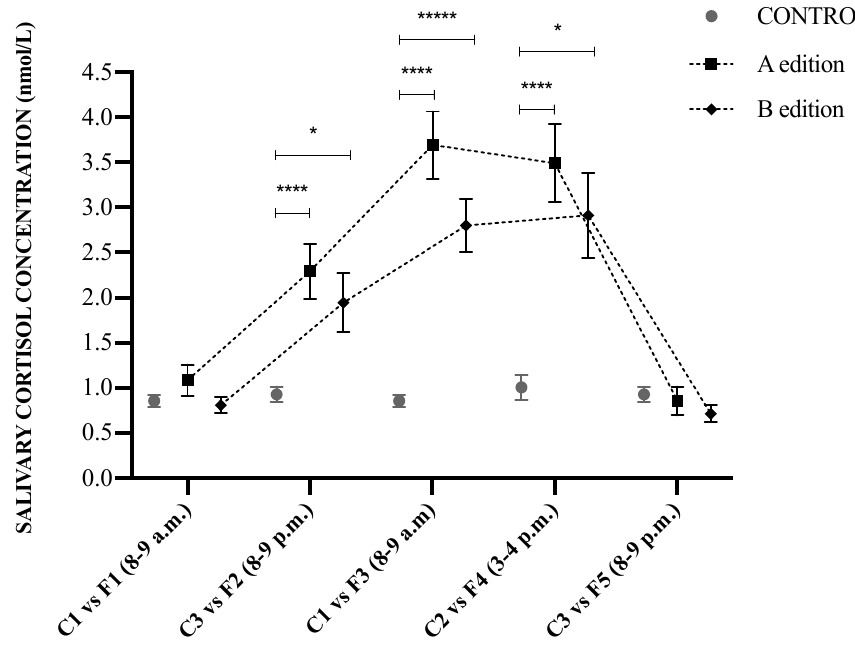
Figure 3. Mean ± SEM salivary cortisol concentrations (nmol/L) from the evaluated horses during the festival days (Fx) and the control group (Cx). Upper asterisks indicate significant differences between obtained salivary cortisol concentrations.